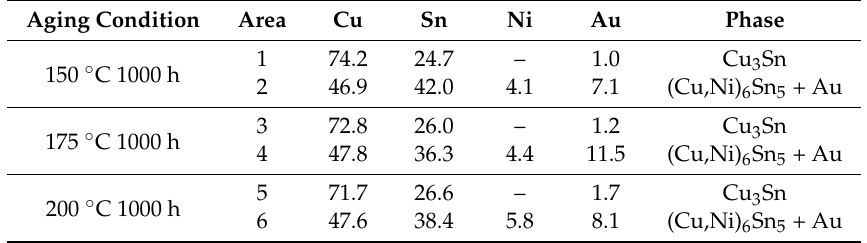
Figure 10. Cross-sectional SEM images of the interfaces between the bonding layer and substrate aged at ( a ) 150, ( b ) 175, and ( c ) 200 °C for 1000 h.